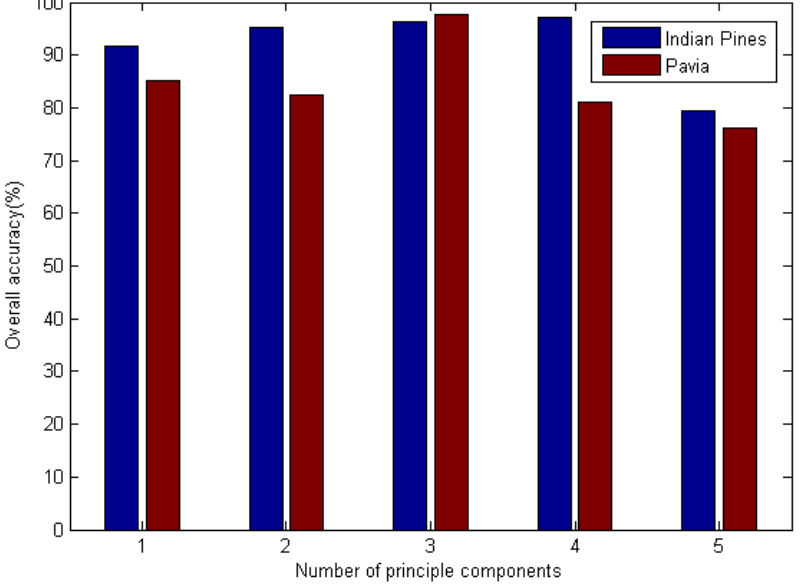
Figure 7. Effect of principal components (JSSC – DBN classifier).